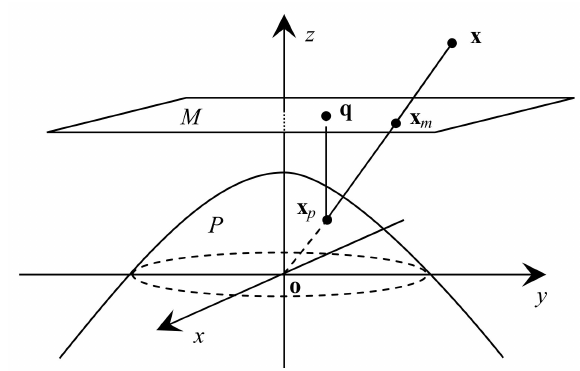
Figure 2. The enhanced unified camera model. z is the optical axis.